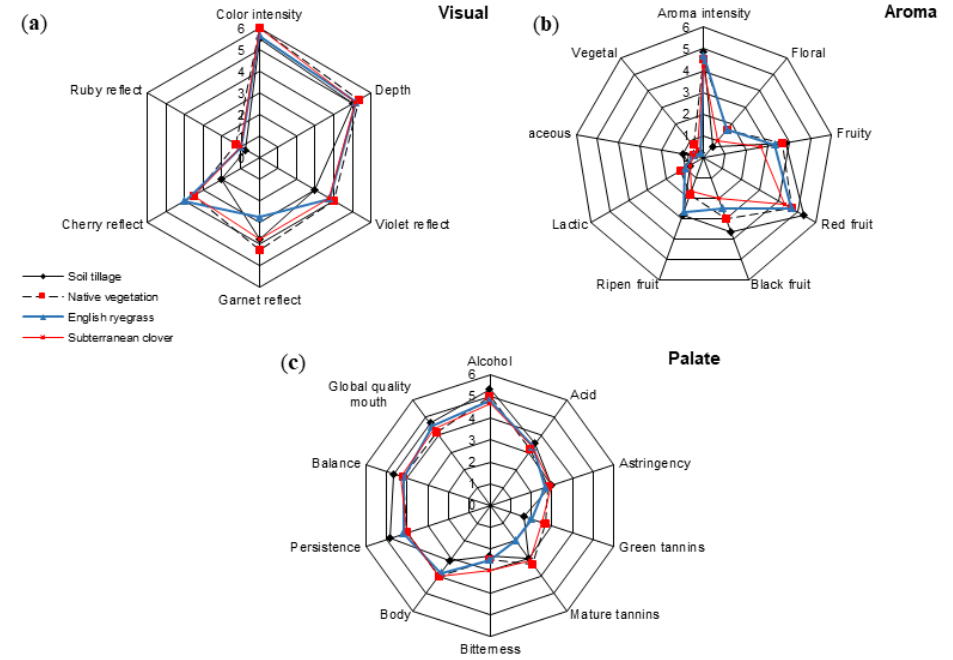
Figure 4. Sensory profile of Mencía wines (average values for 2012–2014) as a function of the soil management system: ( a ) Visual, ( b ) aroma, and ( c ) palate descriptors.